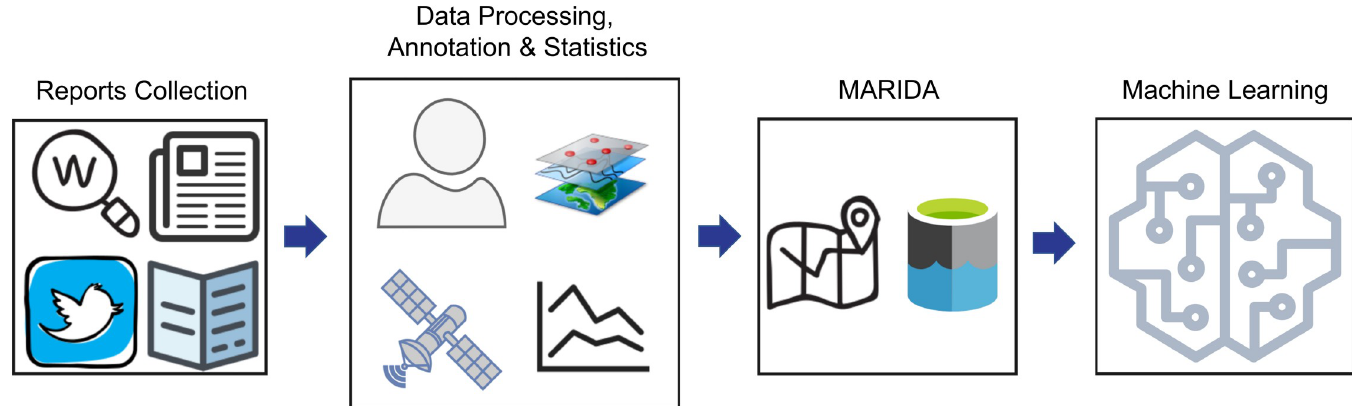
Fig 1. Schematic diagram representing the different steps for the construction of Marine Debris Archive-MARIDA.